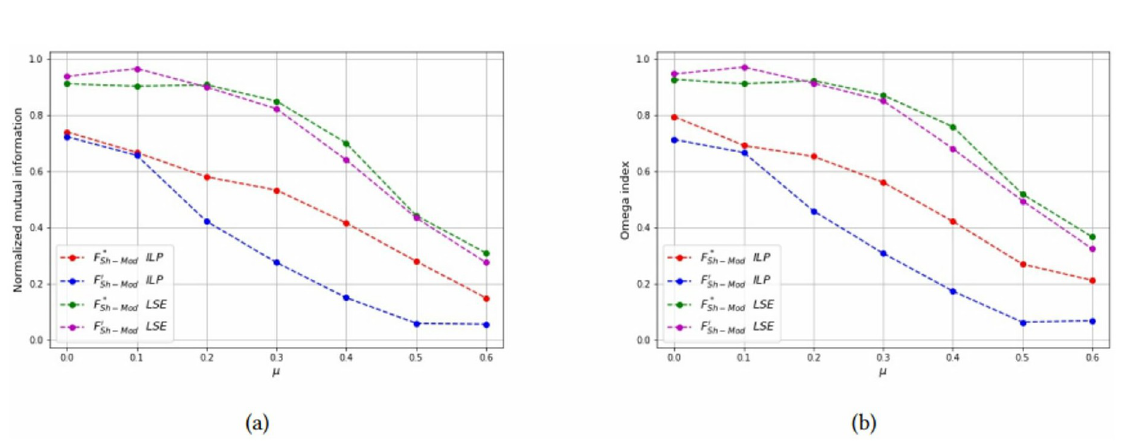
Fig 17. Test results on overlapping communities, parameters p = 2, μ Average Omega for each solution method.